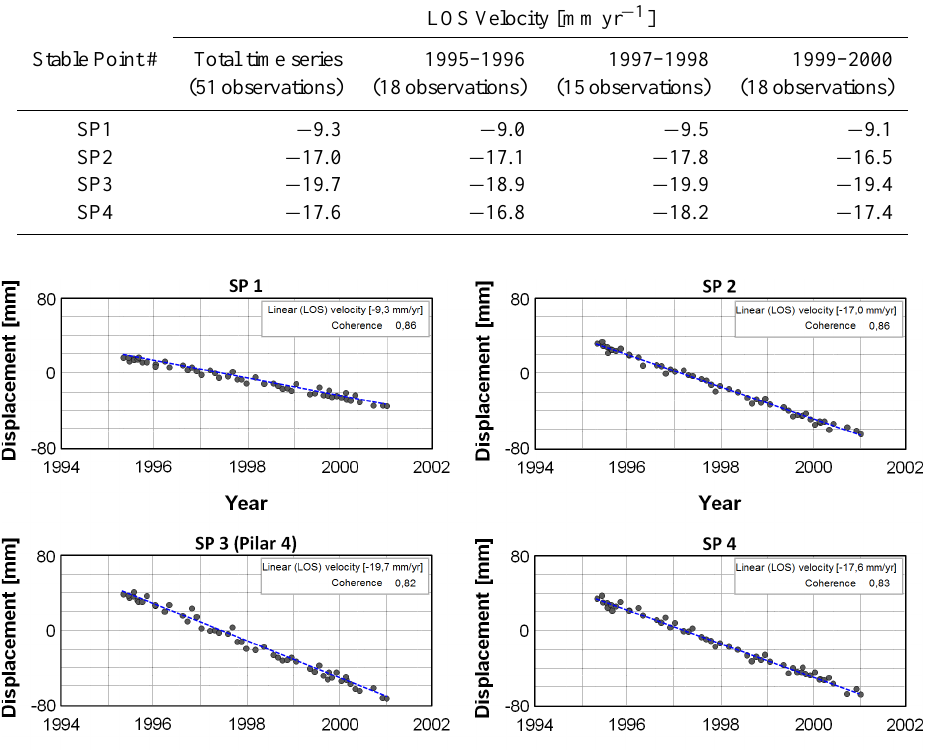
Table 1. Linear deformation rates (LOS) for the four stable points detected on the bridge structure. Three periods of time (1995–1996, 1997–1998, 1999–2000) were defined and compared with the overall period considered in this study. The three partial periods compare well with the overall linear fitting.